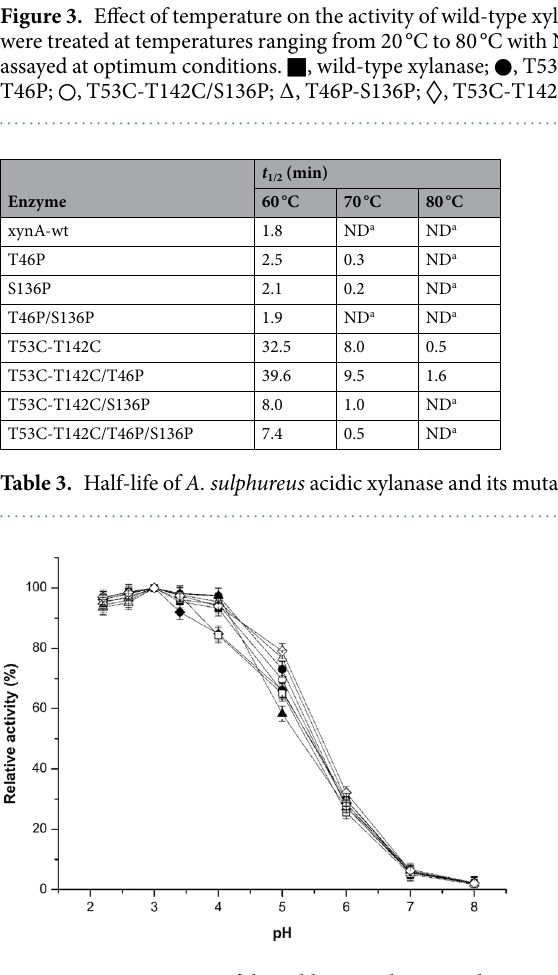
Figure 4. Optimum pH of the wild-type xylanase and its mutants. The purified xylanases were treated under the following conditions and then assayed under optimum conditions. The purified xylanases were assayed at pH values from 2.2 to 8.0 in Na 2 HPO 4 -citric acid buffer. ■ , wild-type xylanase; ● , T53C-T142C; ▲ , T46P; ♦ , S136P; □ , T53C-T142C/T46P; ○ , T53C-T142C/S136P; ∆ , T46P-S136P; ◊ ,